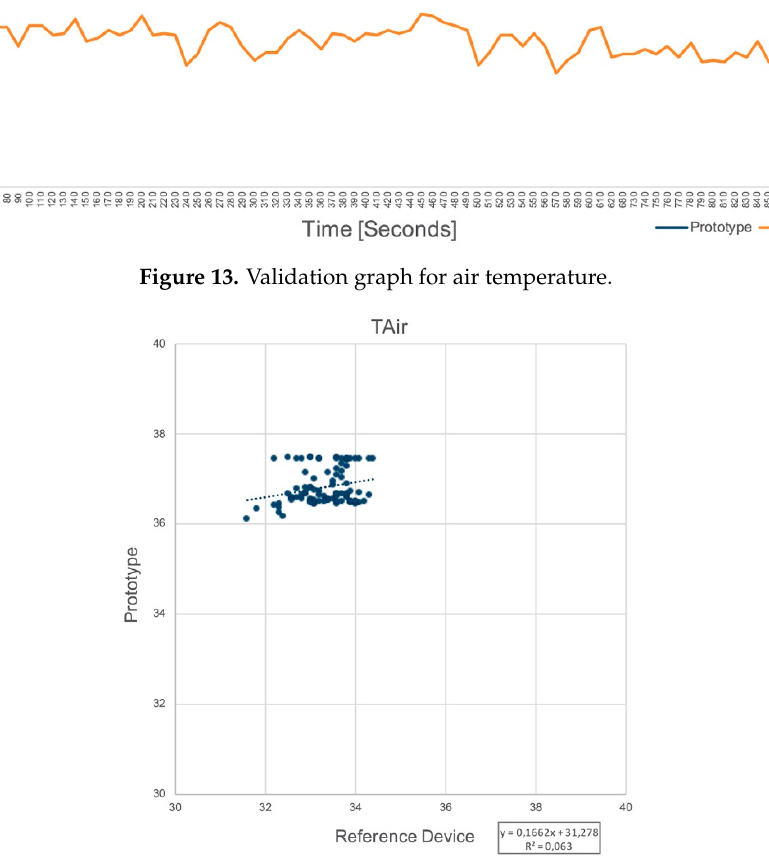
Figure 14. The linear regression graph for air temperature.